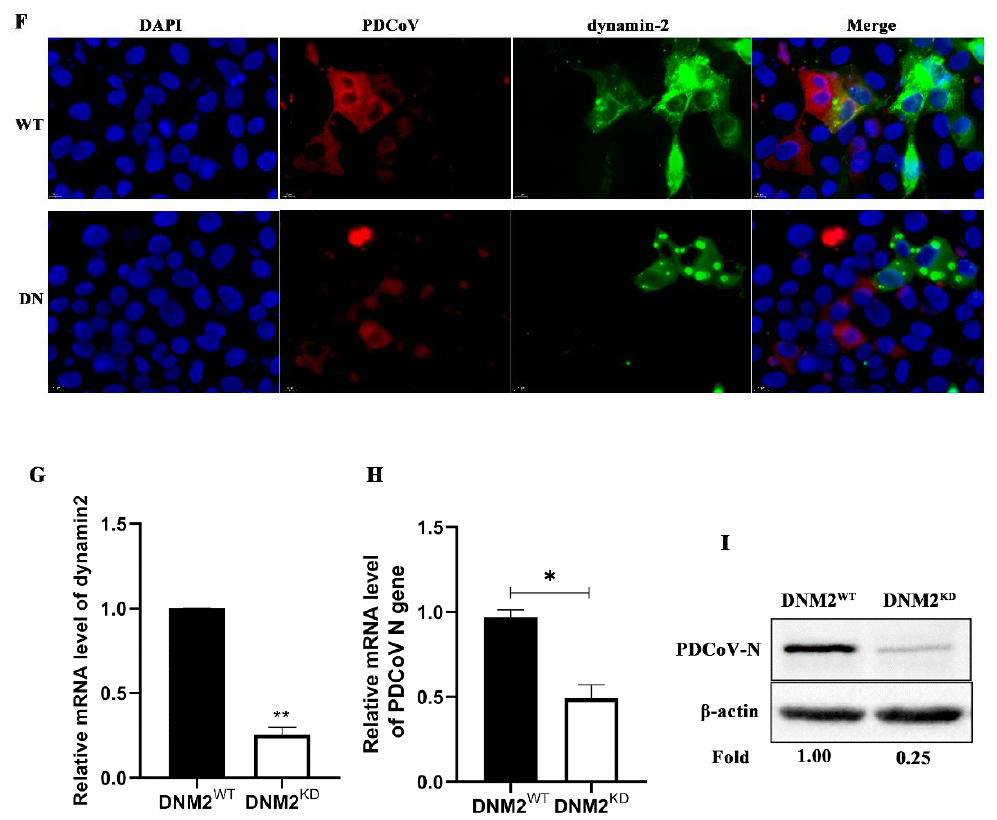
Figure 4. PDCoV entry depends on dynamin. ( A ) PK-15 cells were pretreated with dynasore at 37 ◦ C for 1 h and infected with PDCoV (MOI of 5) at 4 ◦ C for 1 h (binding step), and then shifted to 37 ◦ C for 1 h (entry step). Cells were lysed to determine viral mRNA level by RT-qPCR.Cells were mock-treated or treated with dynasore for 1 h followed by infection with PDCoV (MOI = 0.1). At 24 hpi, mRNA expression levels of total PDCoV were detected by real-time quantitative PCR ( B ) and protein expression levels of intracellular PDCoV were detected by Western blotting ( C ). ( D ) PK-15 cells were pretreated with dynasore with different concentrations at 37 ◦ C for 1 h, followed by incubation with 10 µ g/mL Alexa Fluor 568-labeled transferrin (Tfn) on ice for 30 min, then shifted to 37 ◦ C for 30 min. The cells were fixed and stained with DAPI. Scale bar, 20 µ m. ( E , F ) PK-15 cells were transfected with dynamin-2 wild type (WT) or dynamin-2 dominant-negative (DN), followed by incubation with 10 µ g/mL Tfn or infection with PDCoV 24 h later (MOI = 0.1). At 24 hpi, the cells were fixed and immunostained. Scale bar, 10 µ m. ( G – I ) Dynamin-2 knockdown and normal cells were infected with PDCoV (MOI = 0.1). The knockdown efficiency was verified by qRT-PCR ( G ). At 24 hpi, the viral RNA and N protein levels were determined by qRT-PCR ( H ) and Western blotting ( I ), respectively. * p < 0.05, ** p < 0.01, ns: no significant difference.